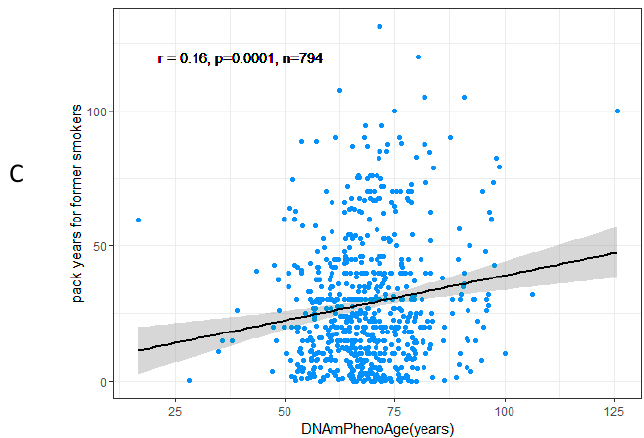
Figure 3. Scatter plots of the association between pack-years and DNA methylation phenotypic age (DNAmPhenoAge) for ( A ) all participants, ( B ) current smokers, and ( C ) former smokers in the Veterans